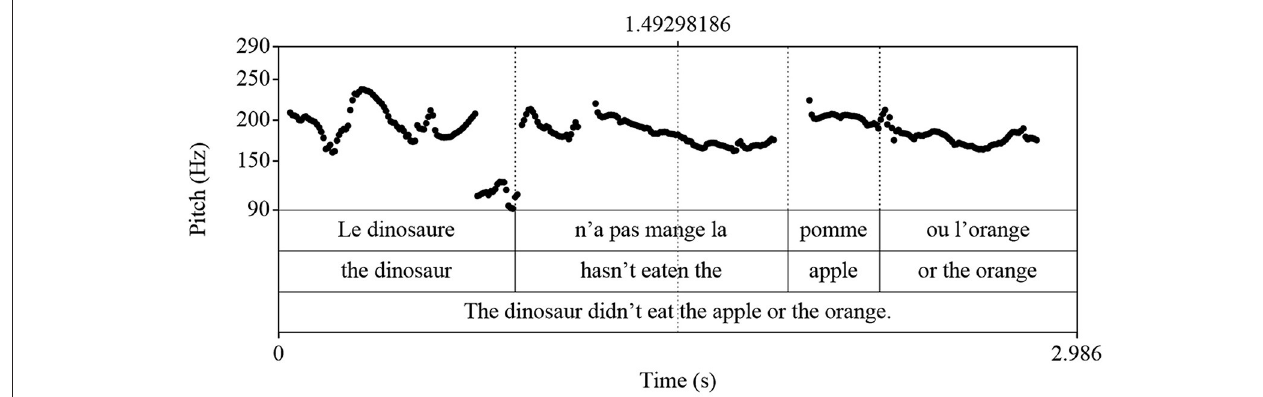
FIGURE 1 | Pitch track of example recording of test sentence with neutral intonation.